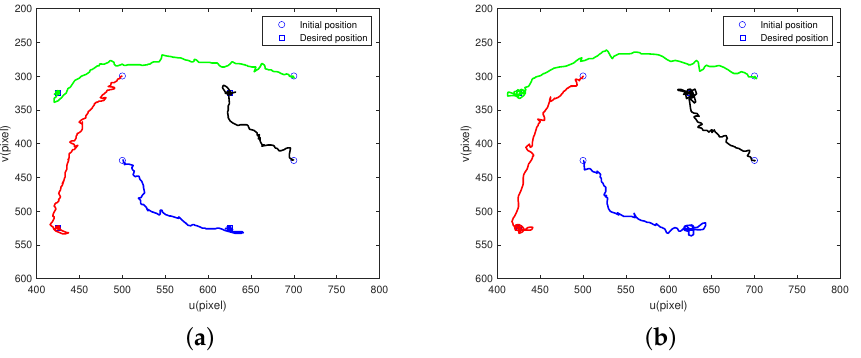
Figure 9. Trajectories of the image features of comparative simulations with time-varying external disturbances for the 2-DOF robot manipulator. ( a ) Trajectories of the image features in Case 3. ( b ) Trajectories of the image features in Case 4.